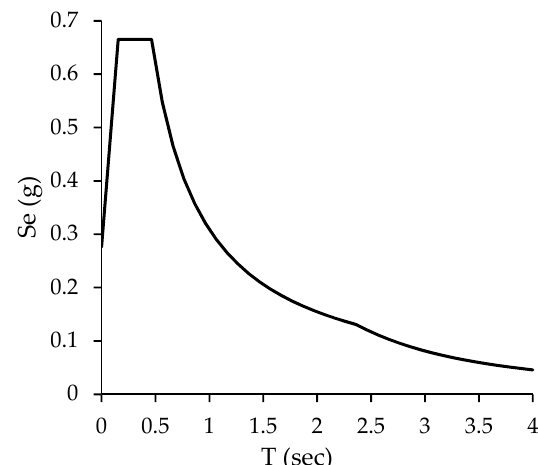
Figure 7. Elastic response spectrum adopted for the case study.